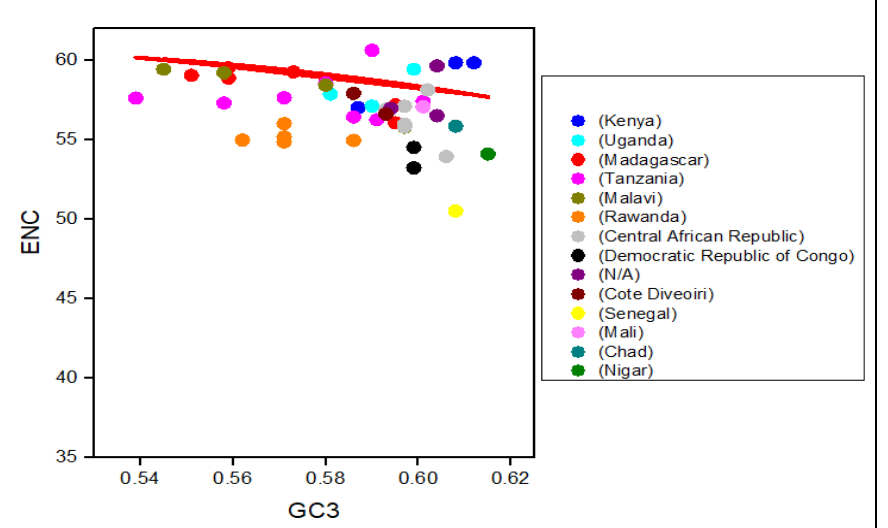
Figure 4. ENC-GC3 plots of 50 RYMVs strains: The effective number of codons (ENC-values, Y -axis) was plotted against the GC-content at the third synonymous codon positions (GC3-values, X -axis). The ENC values ranged from 30 to 61. Interestingly, all the RYMV isolates were between the 55.92 and 59.93 range and slightly below the 61, suggesting that codon usage bias is caused by selection pressure. The continuous red line represents theoretical ENC values for random codon usage as a function of GC3.